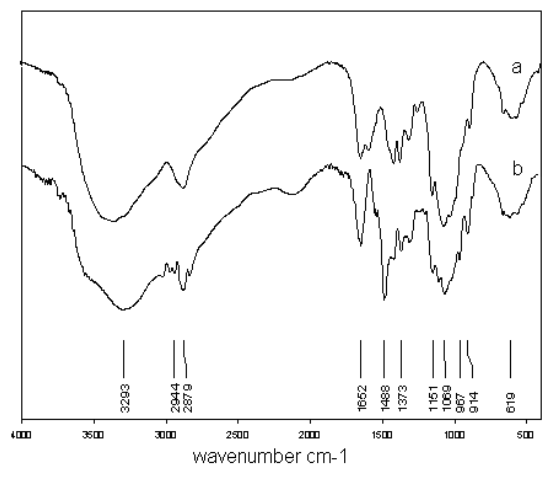
Figure 1: FTIR spectra of chitosan (a) and HTCC (b).